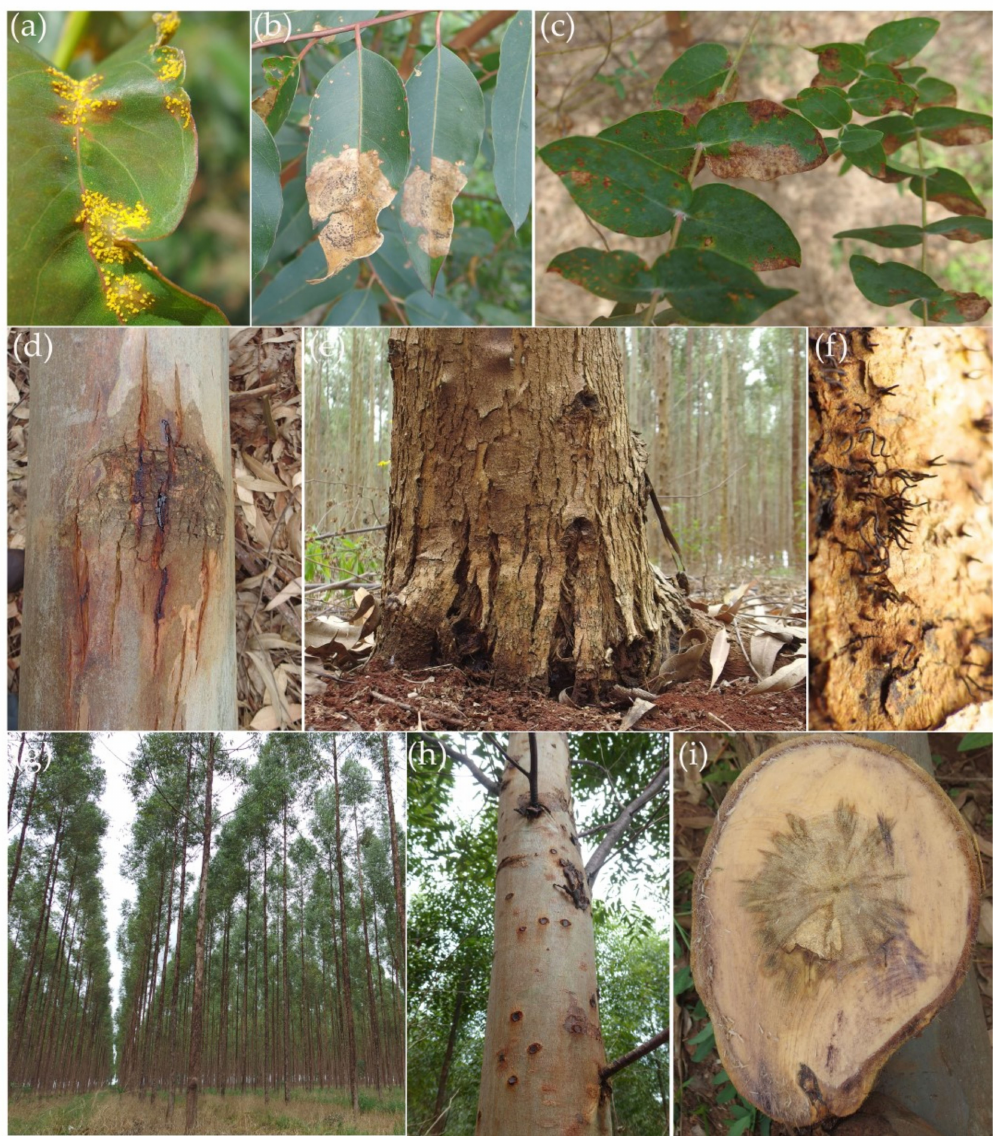
Figure 2. Symptoms of fungal diseases in Paraguayan eucalypts plantations. ( a ) Myrtle / Eucalypt rust symptoms on mature leaf, ( b ) Coniella leaf spot, ( c ) Calonectria blight, ( d ) Botryosphaeria canker, ( e ) Chrysoporthe canker, ( f ) Chrysoporthe sp. on eucalypt bark, ( g , h ) Teratosphaeria stem canker, ( i ) cross section showing a stem disease caused by unknown pathogen present in Eucalyptus urophylla x